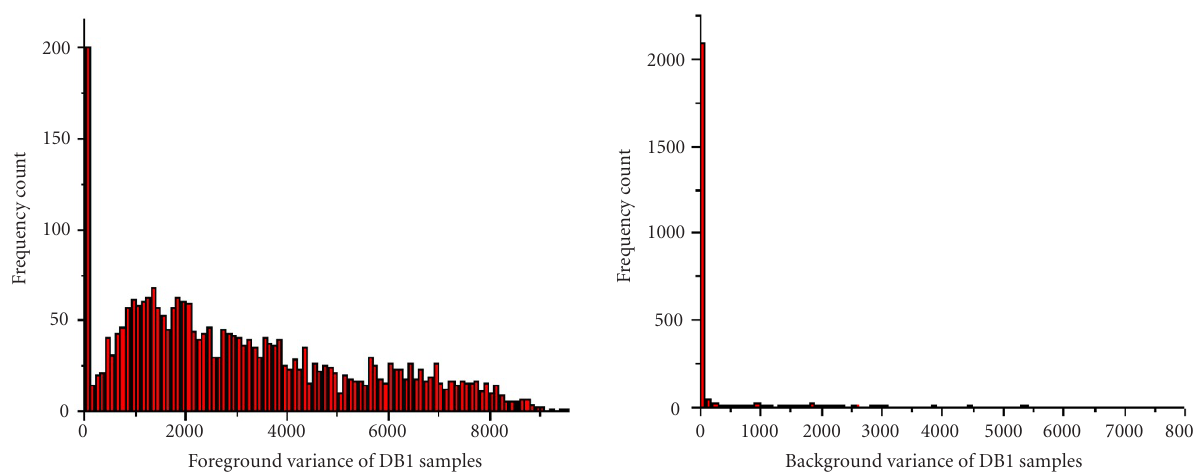
Figure 16: The block variance Var of the samples. The horizontal coordinate represents the value of the block variance while the vertical coordinate represents the frequency count of the value.